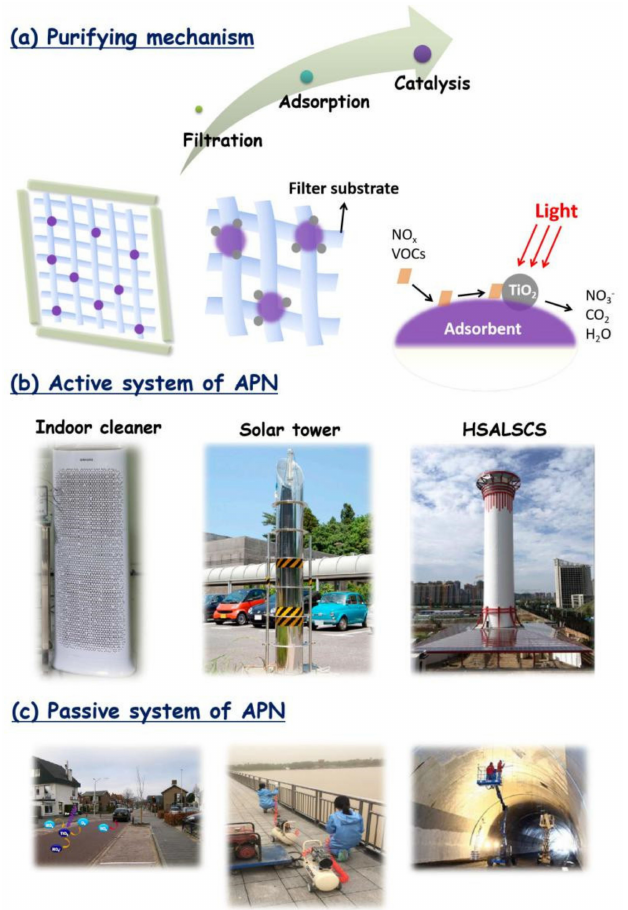
Figure 8. ( a ) The mechanism of active APN systems; ( b ) prototype cleaning systems at different scales. Reprinted with permission from reference [238,242,243] and ( c ) passive system of APN with TiO 2 embedded concrete pavements applied on roads, bridges, and tunnels. Reprinted with permission from reference